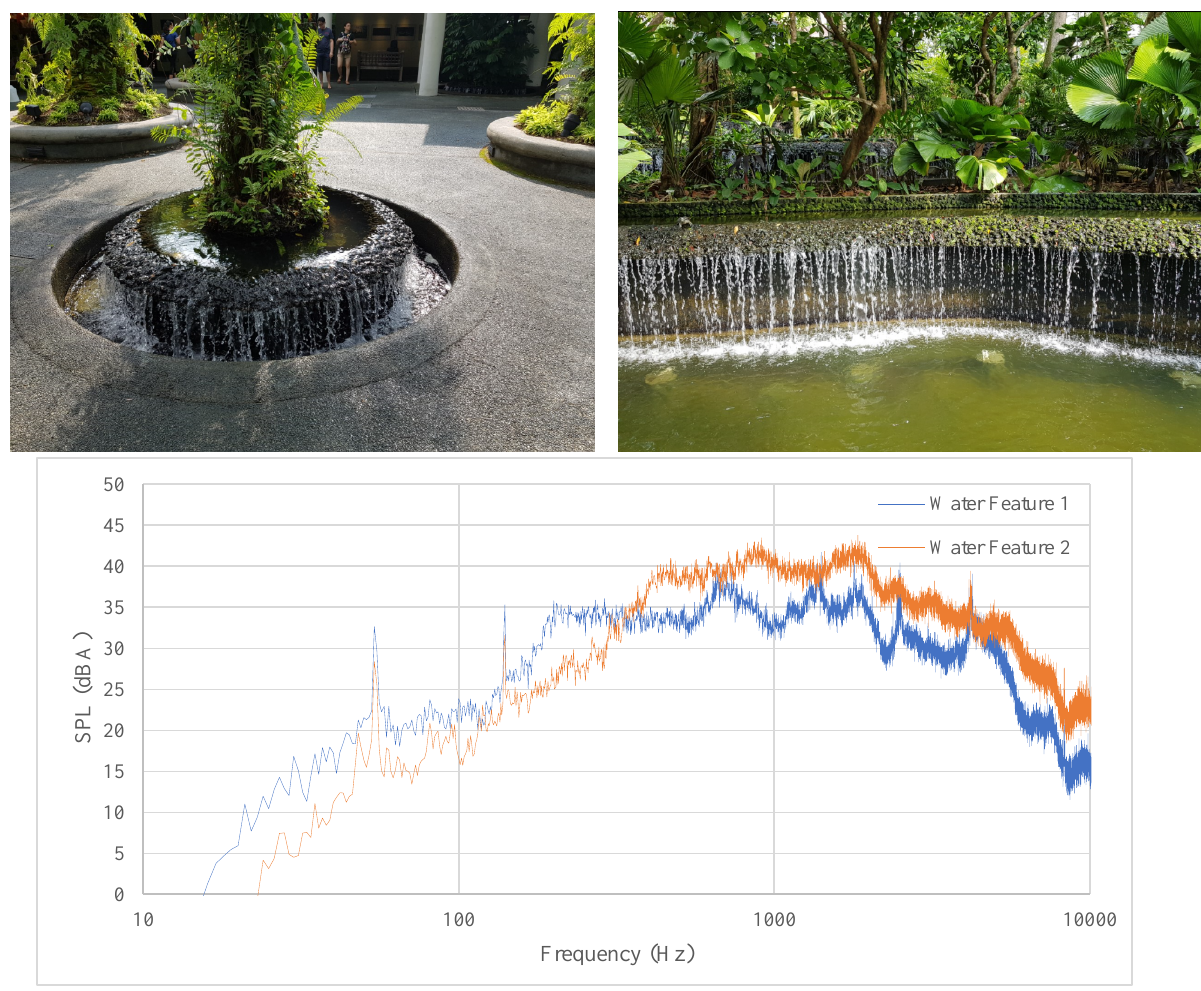
Figure 6: The average frequency spectrum and spectrogram in dBA for the north eastern portion of the gardens with dominant cicada sound